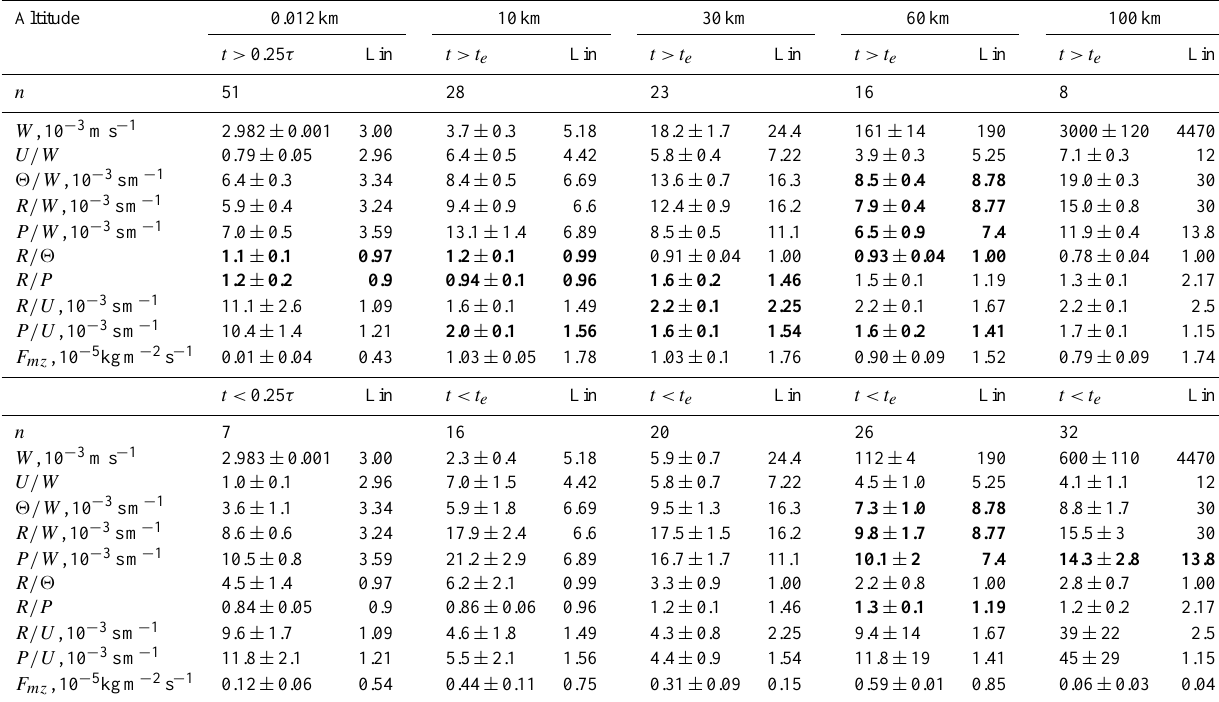
Table 2. Same as Table 1 but for AGW with c x = 100ms − 1 .